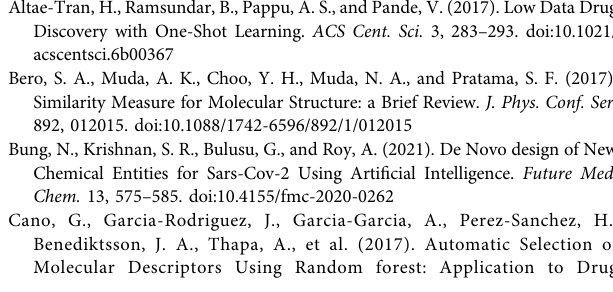
Supplementary Table S1 | Statistics on the anticoronavirus dataset according to their origin (bioassays vs. literature) and their type (experiments, targets, etc). Composition of the training, validation and test set in terms of active and inactive molecules are indicated. Supplementary Table S2 | Performances of all 11 algorithms using different splitting ratios (80/10/10 vs. 60/202/20) and methods (random vs. scaffold split) on different datasets (heterogenoeous vs. homogeneous). Supplementary Table S3 |Hyperparameters ’ tuning and optimization for thethree best performers: GCN, DAG and RF. Supplementary Table S4 | Performances of the optimized algorithms GCN, DAG and RF in terms of accuracy, F1-score, sensitivity and speci fi city, on different subsets of the